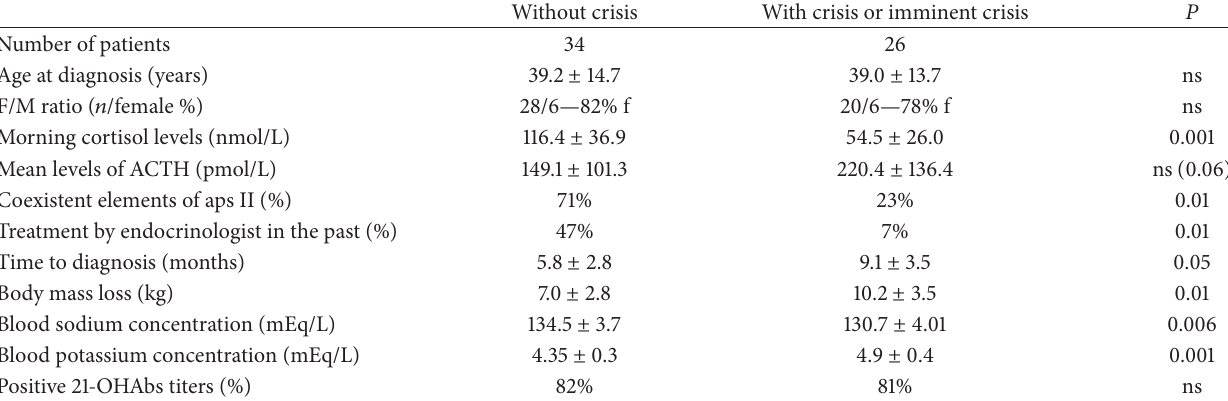
Table 1: Comparison of two groups: with and without crisis at the time of adrenal insufficiency